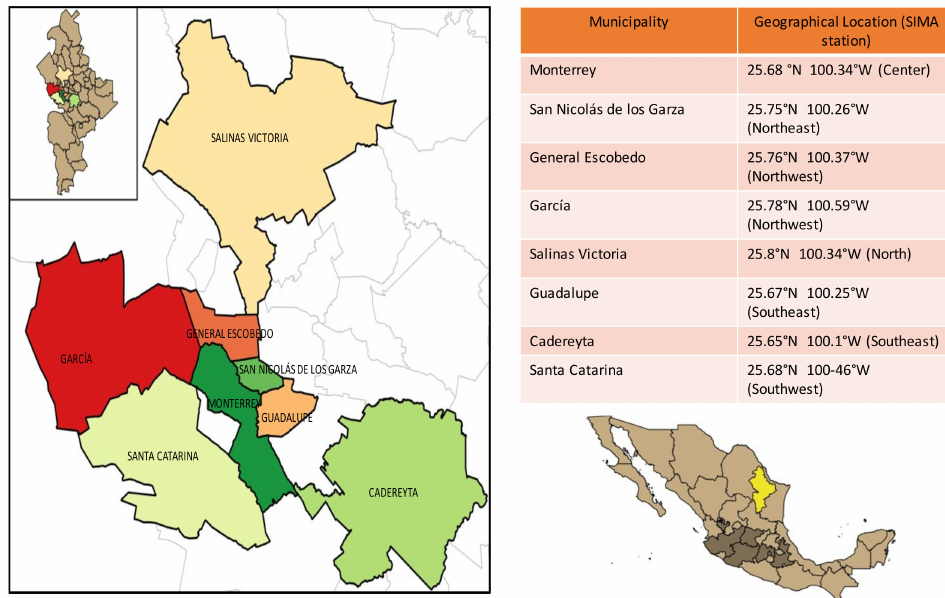
Figure 1. Location of municipalities of the study area in Monterrey, Nuevo Leon,